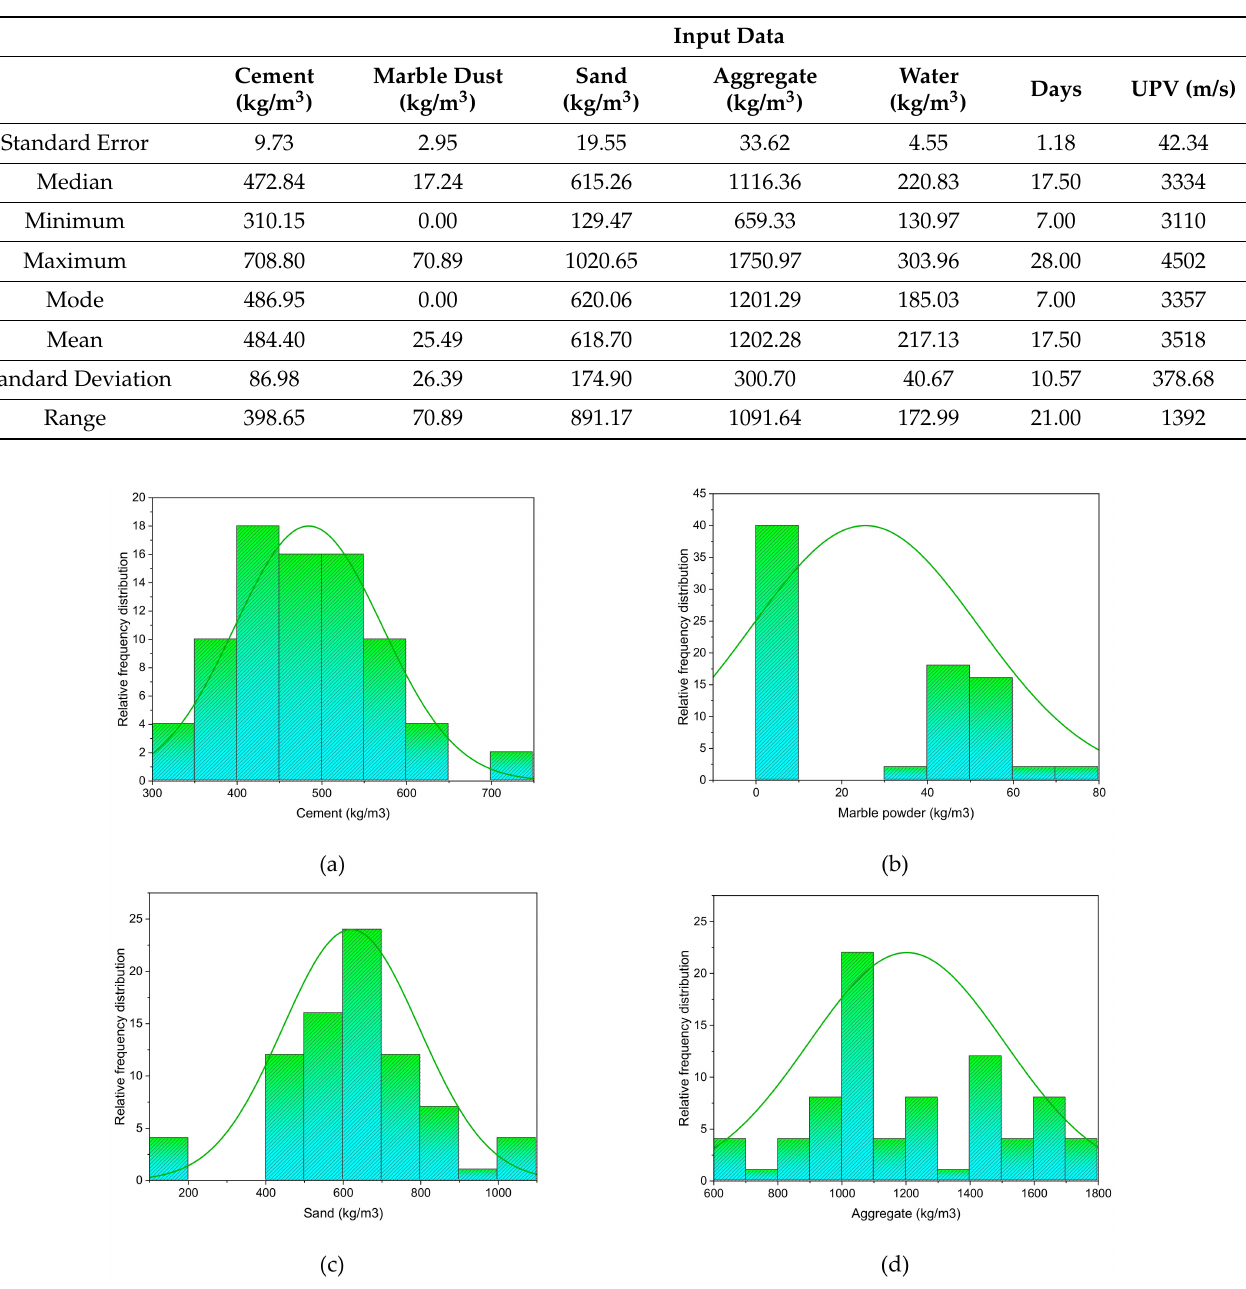
Table 3. Details of input data.